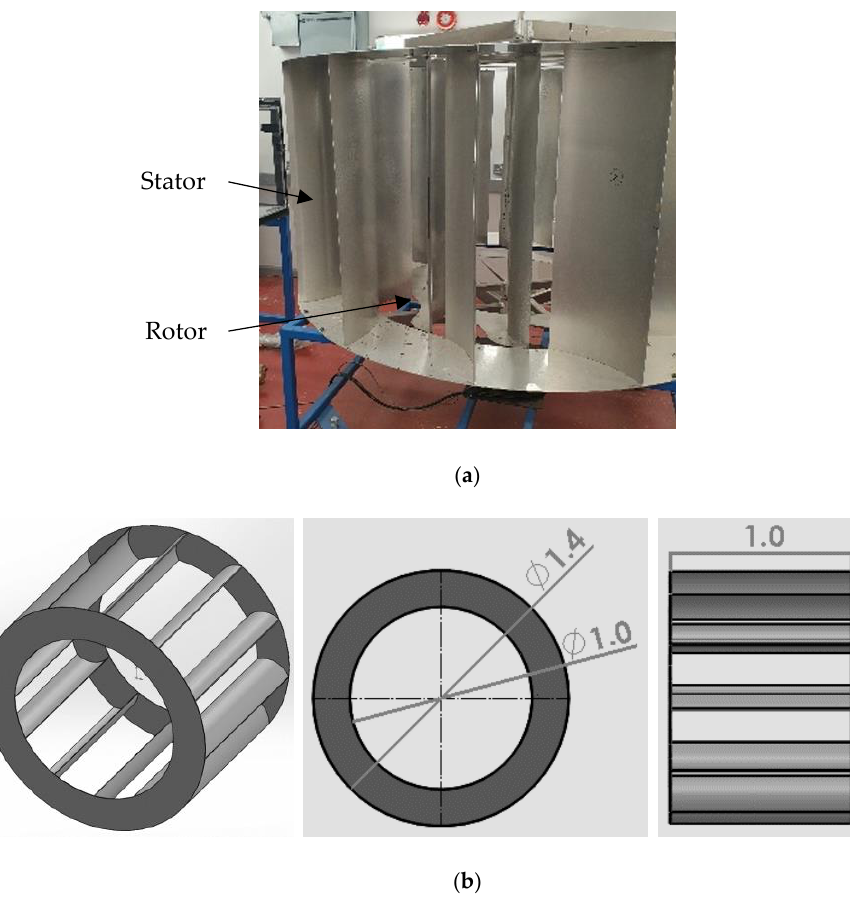
Figure 1. ( a ) Real-world VAWT model (with stator); ( b ) CAD model of the VAWT without stator.